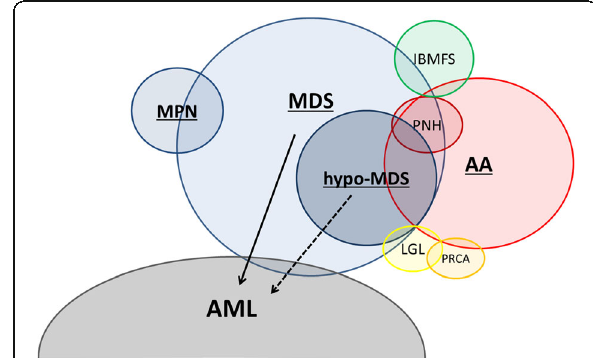
Fig. 1 Overlap of bone marrow failure syndrome and progression to leukemia [1]. AA aplastic anemia, MDS myelodysplastic syndromes, IBMFS inherited bone marrow failure syndrome, LGL large granular lymphocytosis, PRCA pure red cell aplasia, PNH paroxysmal nocturnal hemoglobinuria, MPN myeloproliferative neoplasm, AML acute myeloid